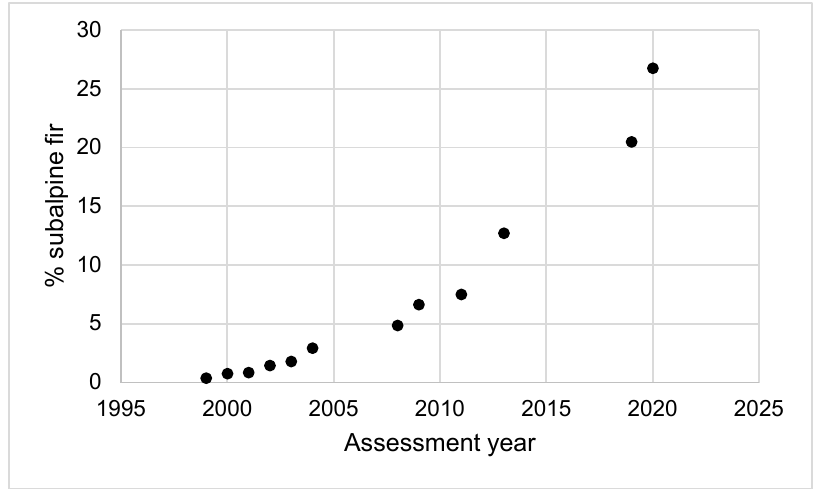
Figure 9. Cumulative downed subalpine fir recorded at each assessment time expressed as a percentage of the total live and dead subalpine firs at plot establishment. Table 6. The average and median number of years from D. confusus attack to snag (tree code 6) in plots; the average number of years for trees killed by D. confusus and other factors to fall. # Years Dead to Down (Avg. ± S.E.) Attack to Snag (Avg. ±